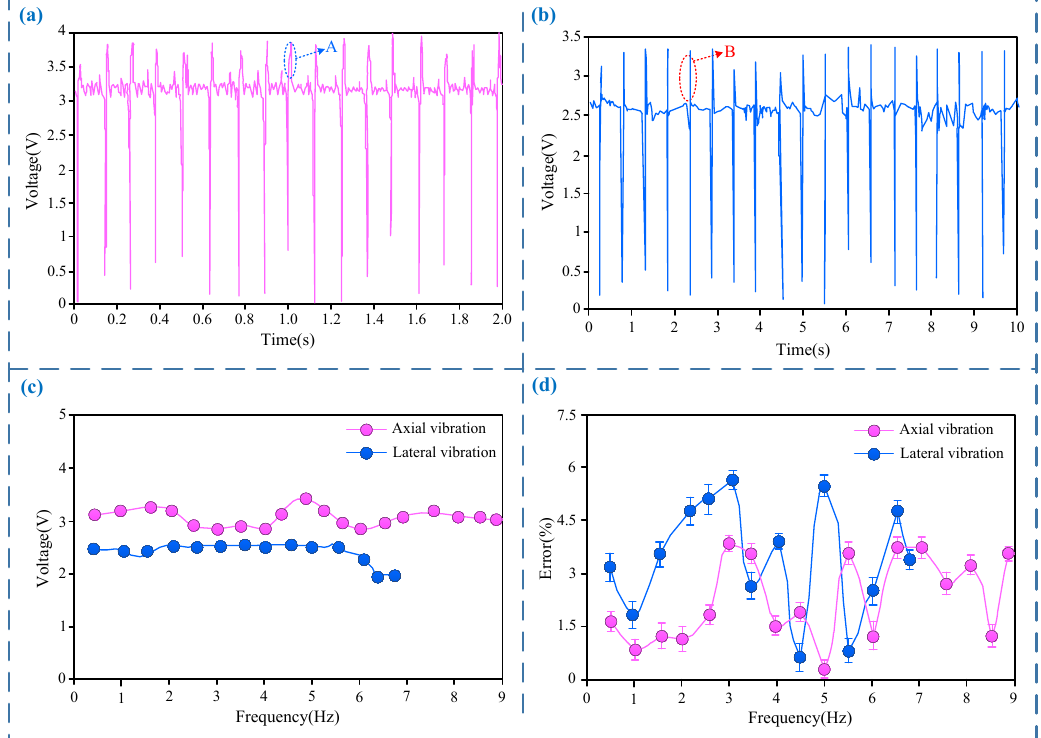
Figure 4. Results of vibration tests. ( a ) Output voltage when the axial vibration frequency is 8.5 Hz; ( b ) output voltage when the lateral vibration frequency is 8.5 Hz; ( c ) output voltage of axial and lateral vibration at different frequencies; and ( d ) measurement error of axial and lateral vibration at different frequencies.